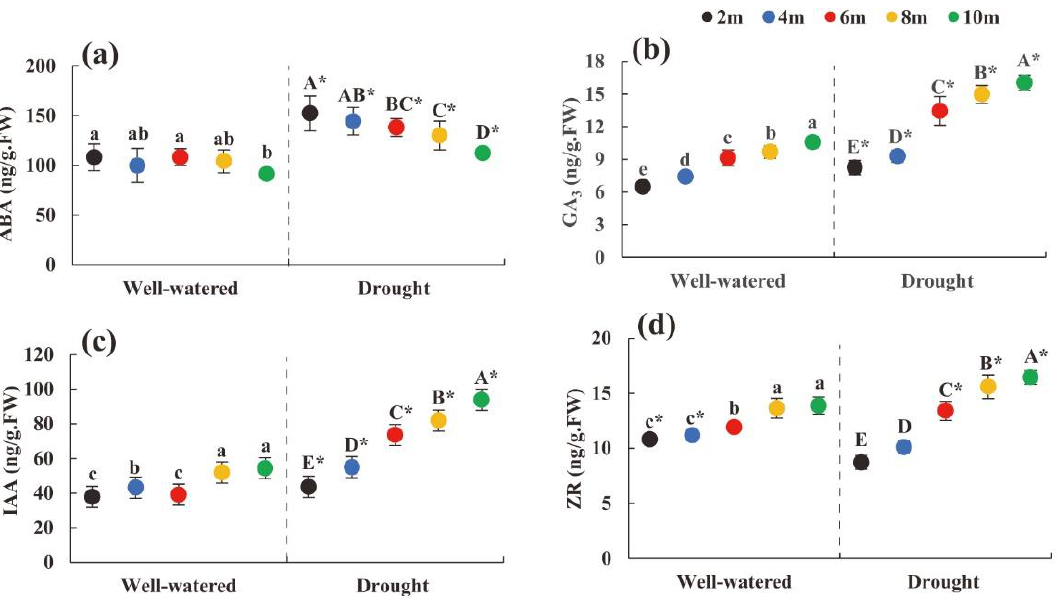
Figure 5. Changes in hormone content index parameters of heteromorphic leaves with tree height under different soil moisture conditions. Note: ( a – d ) were changes in abscisic acid, gibberellin, indoleacetic acid, zeatin riboside content with different tree heights under different soil moisture condition. The black dot indicates the height of the 2 m tree, the blue dot indicates the height of the 4 m tree, the red dot indicates the height of the 6 m tree, the yellow dot indicates the height of the tree 8 m, and the green dot indicates the height of the 10 m tree; lowercase and uppercase letters represent the significance of the difference between different sampling heights under suitable soil moisture conditions and soil drought stress conditions, and * represents the comparison of the same height under different habitats ( p < 0.05). ABA: abscisic acid; GA 3 : gibberellin; IAA: indoleacetic acid; ZR: zeatin riboside.